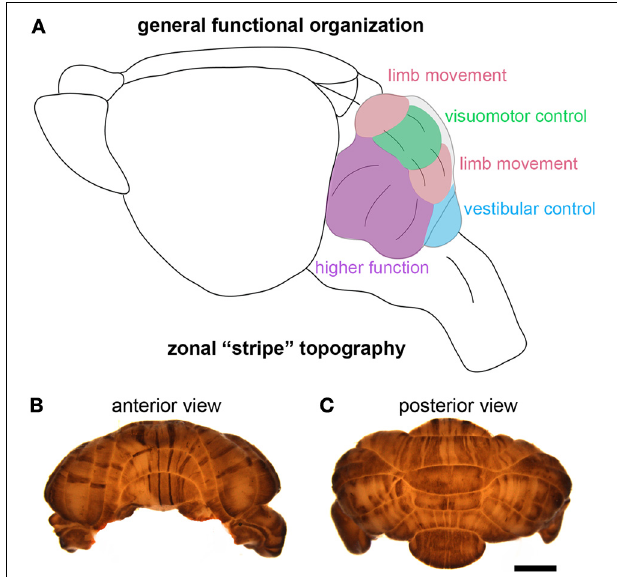
FIGURE 4 | The cerebellum is highly compartmentalized into functional regions. (A) Schematic illustrating the division of the cerebellum into behaviorally relevant domains. The cartoon is a simplified model of the functional cerebellum and is based on functional imaging, human and animal lesions, afferent connectivity, electrophysiology, and animal behavior studies. (B,C) Wholemount immunohistochemical staining of the mouse cerebellum—zebrin II expression reveals the intricate patterning of the cerebellum into zones. The scale bar in (C) = 2mm (also applies to (B)